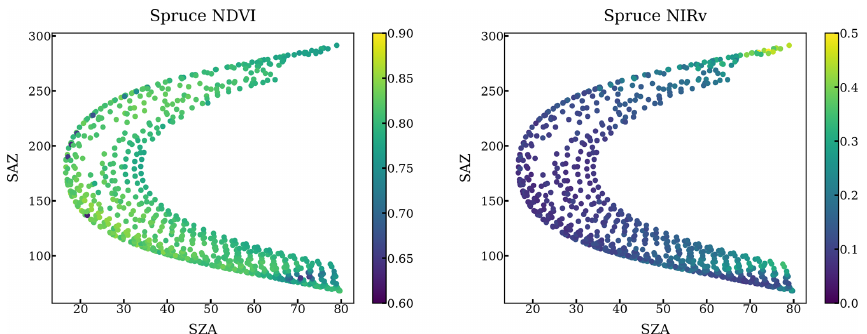
Figure A3. NDVI and NIRv of all scans targeting a spruce at different solar azimuth angles and solar zenith angles throughout a year.